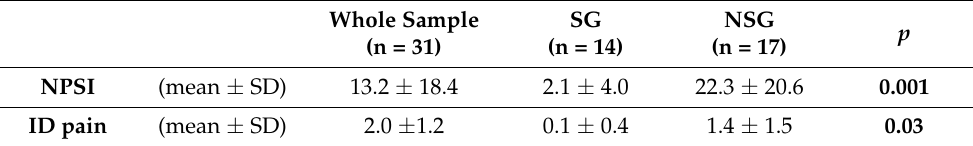
Table 4. Pain of the whole sample and in sport and no-sport